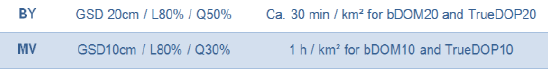
Table 2. Computing times for TrueDOP derivation